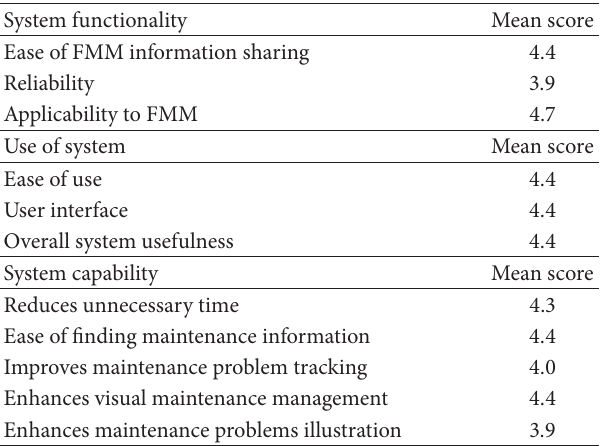
Table 1: System evaluation